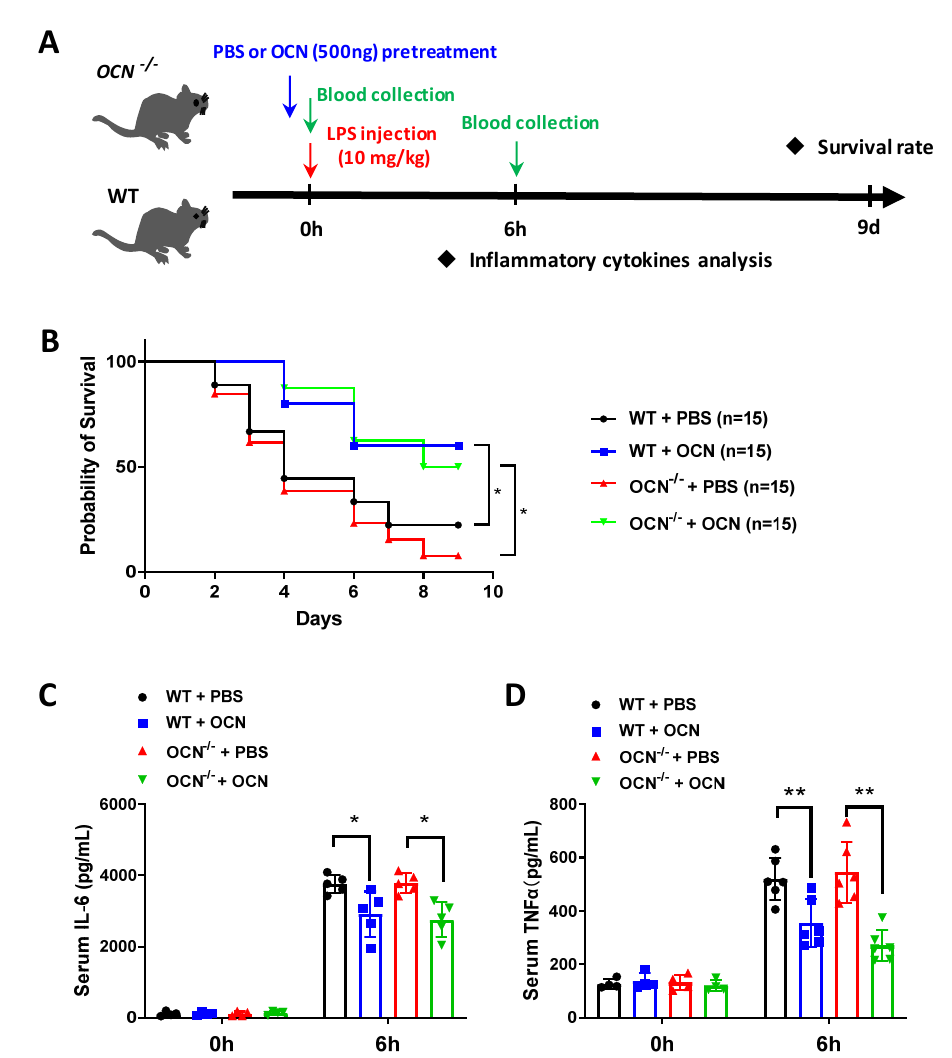
Figure 1. OCN attenuates LPS-caused detrimental effects in WT and OCN − / − mice. ( A ) Experimental design for the LPS-induced acute inflammation. The OCN − / − and WT mice were injected intraperi- toneally with PBS or OCN (500 ng) followed by LPS (10 mg/kg) treatment. Mice survival rate and serum inflammatory were analyzed in each time point, accordingly. ( B ) Survival curves of OCN − / − and WT mice treated with PBS or OCN in response to LPS stimulation. Sample sizes are presented in brackets ( n = 15). * p < 0.05, as compared to PBS. ( C , D ) ELISA analysis of serum levels of IL-6 ( C ) and TNF α ( D ) in OCN − / − and WT mice with PBS or OCN pretreatment after 6h of LPS administra- tion. Sample sizes are indicated as dots in each column. Data are presented as mean ± SD. * p < 0.05 and ** p < 0.01, as compared to PBS.